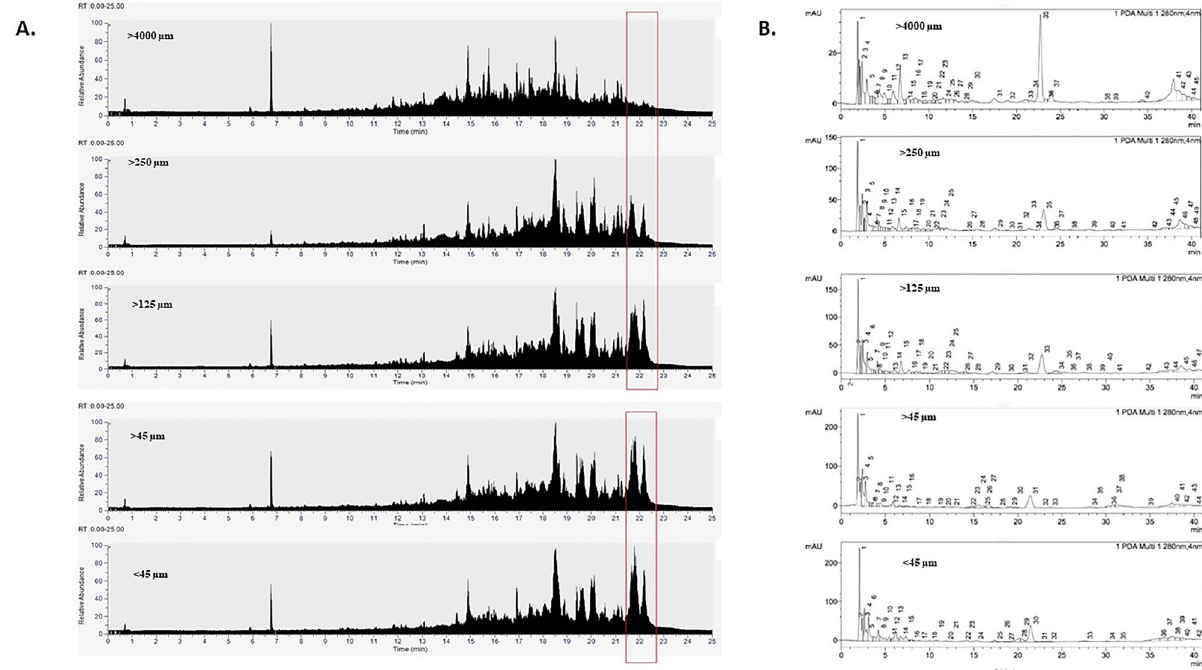
Figure 3. Mass Spectrometry analysis of S. cristaefolium extracts with varying particle sizes. ( A ) Comparative HR-ESI–MS analysis showing different metabolite compositions. The red box indicates changes in phytochemical composition. ( B ) HPLC analysis of phenolic compounds showing increased concentration in samples with smaller particles. Known standards are listed as follows, 1. EGC-Epigallocatechin; 2. PCA- Protocatechuic Acid; 3. C-Catechin hydrate; 4. ECG-Epicatechin gallate; 5. EGCG-Epigallocatechin gallate; 6.